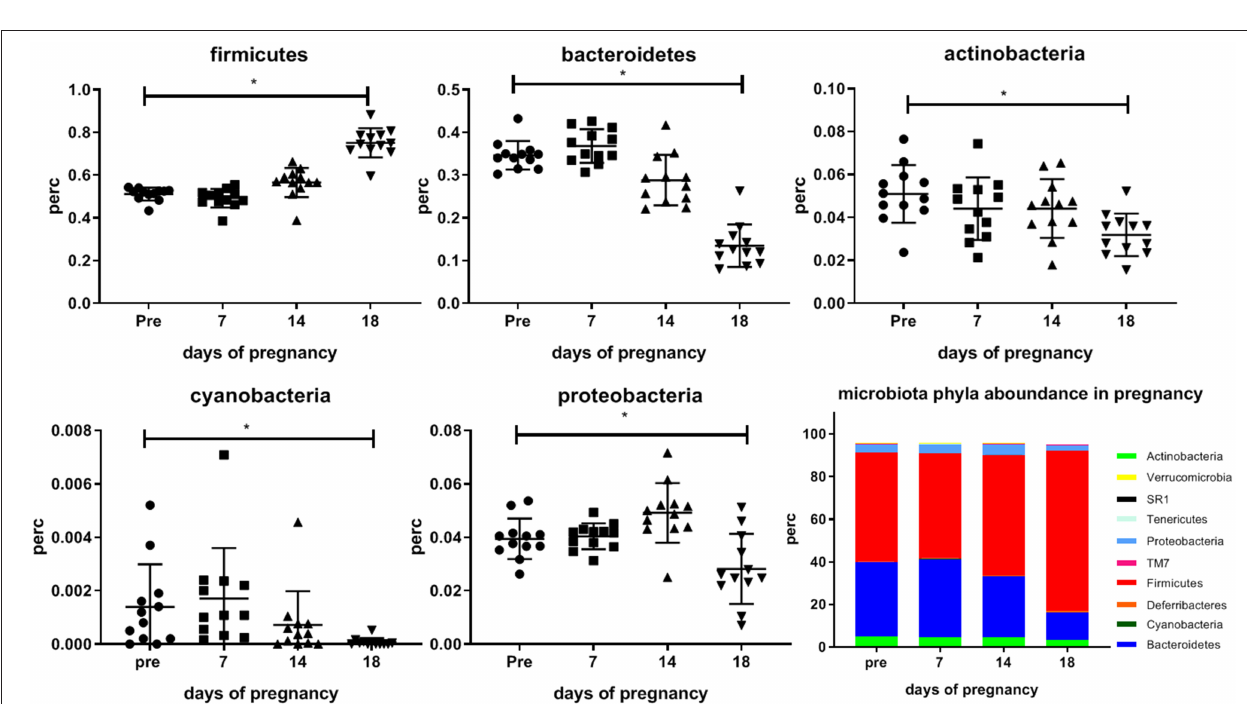
FIGURE 3 | Abundance of the bacterial phyla (Firmicutes, Bacteriodetes, Actinobacteria, Cyanobacteria, and Proteobacteria which significantly differ during pregnancy as compared with pre-pregnancy in the feces of conventional mice measured pre-pregnancy (pre) and during pregnancy at days 7, 14, and 18. Bottom right graph shows stack bars for pre-pregnancy and the 3 days of pregnancy, showing the percentage abundance of the all bacterial phyla present in the feces of these mice. (12 conventional mice were longitudinally studied from pre-pregnancy until the end of pregnancy). *Significantly different from pre-pregnancy (Friedman’s test, followed by Dunn’s post-test, p <